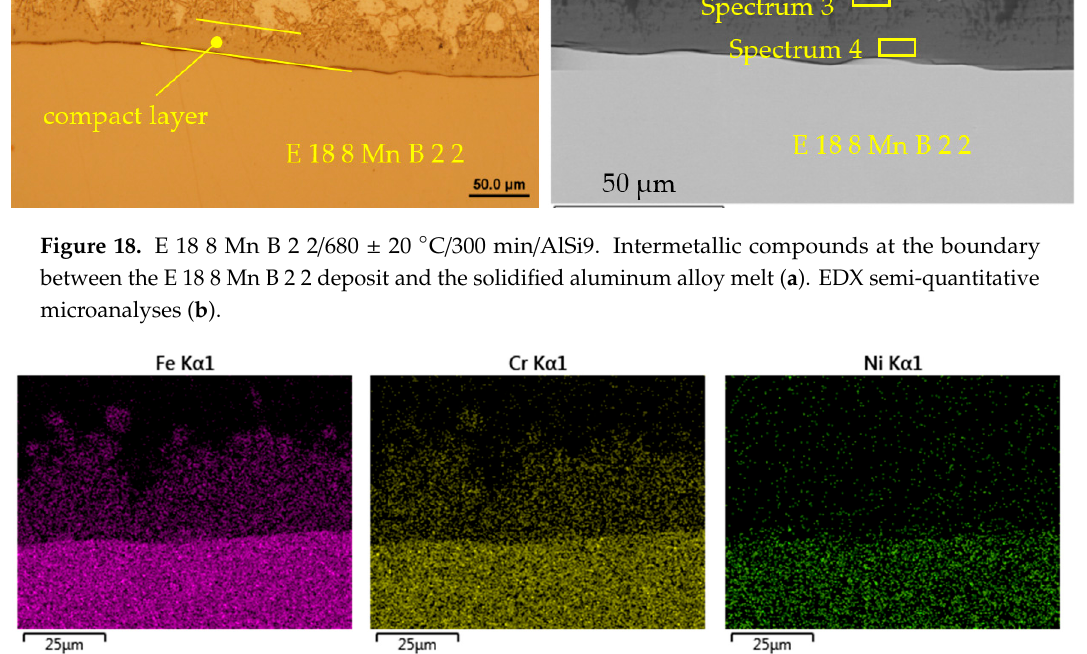
Table 9. E 18 8 Mn B 2 2/680 ± 20 °C/120 min/AlSi9. EDX semi-quantitative microanalyses.